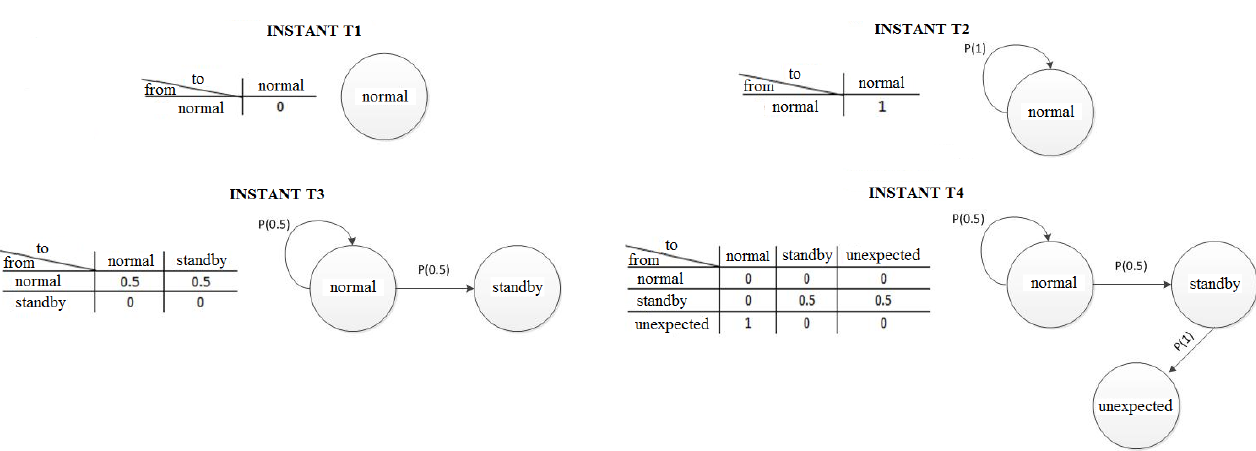
Figure 5. Probability matrix and Markov chain at each instant of time in accordance with Figure